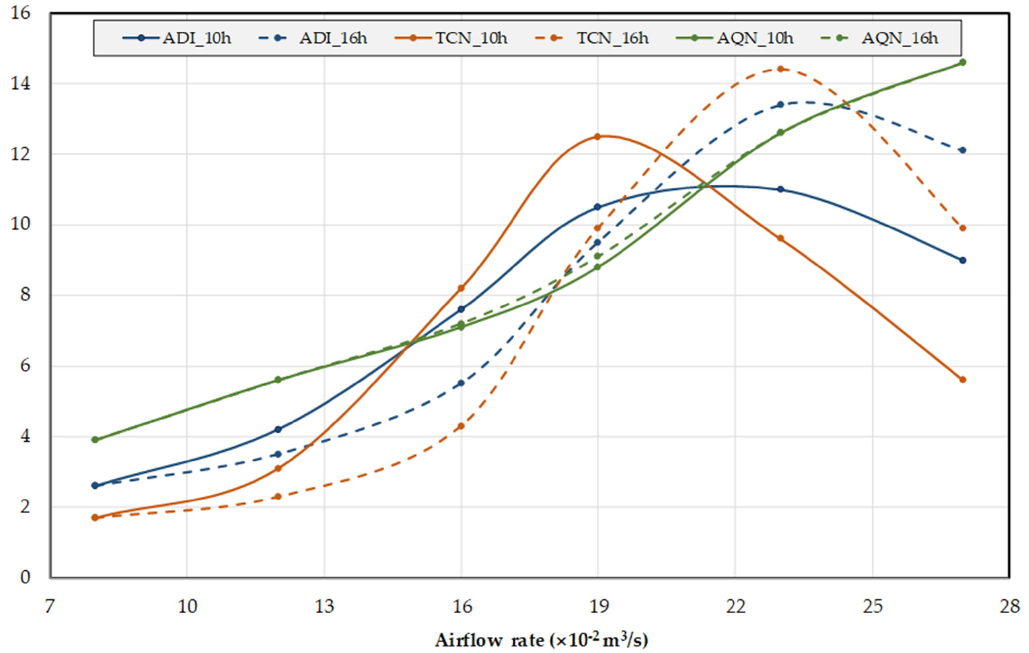
Figure 6. Evolution of the Thermal Comfort Number (TCN), Air Quality Number (AQN), and Air Diffusion Index (ADI), at 10 h and at 16 h.